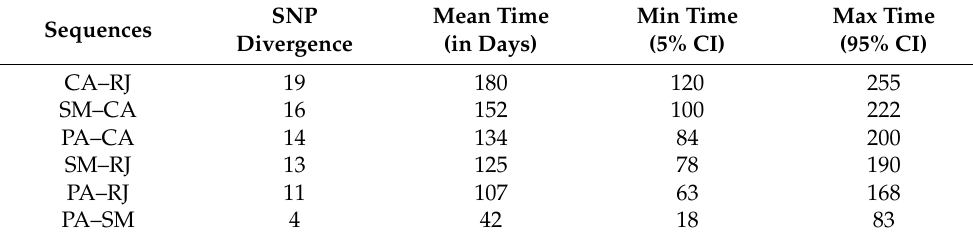
Table A4. Time of divergence between the AYBA-RS genome